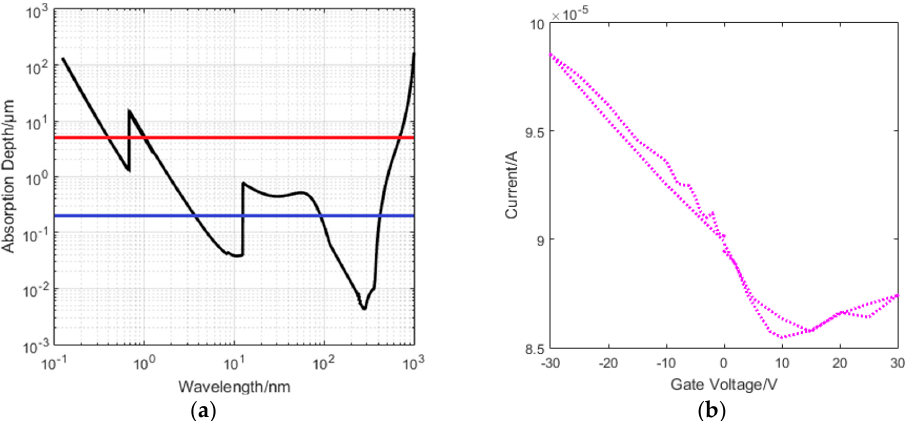
Figure 10. ( a ) the wavelength dependence of photon absorption length for silicon. The red and blue lines show the absorption depth at 650 nm and 405 nm laser wavelengths respectively; and ( b ) showing the current as a function of the gate voltage with the Dirac point at approximately 10 V.